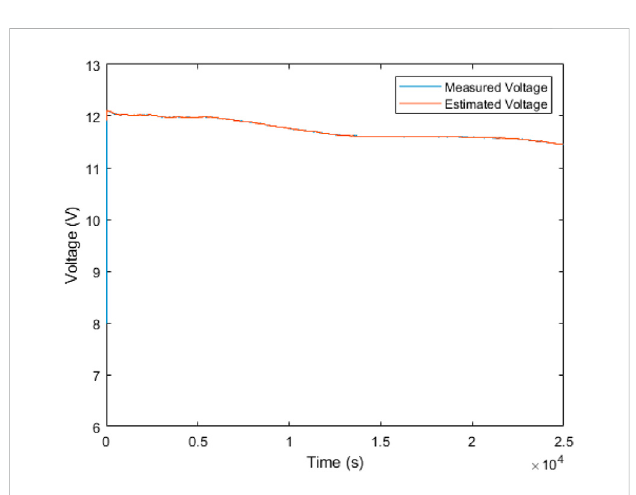
FIGURE 6 Measured vs. the estimated voltage response of the fi rst- order ECM.